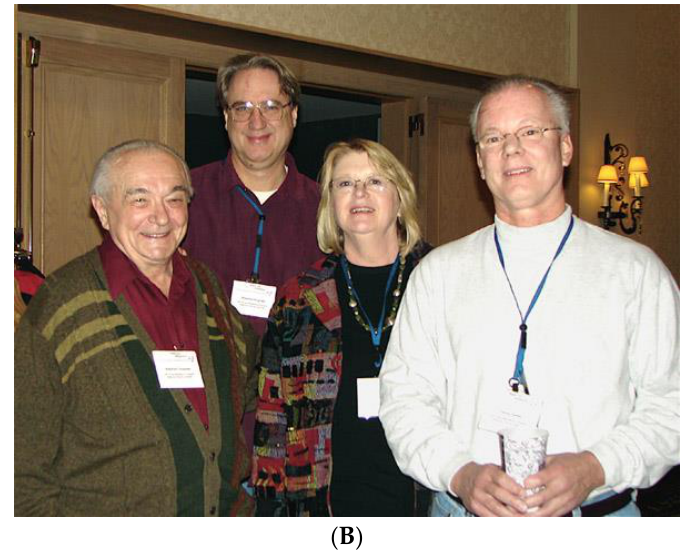
Figure 1. Steve Oroszlan in his element at meetings. ( A ) With Reuben Harris of the University of Minnesota; ( B ) with Steve Hughes, Gisela Heidecker, and Dave Derse, his colleagues at the NCI HIV Drug Resistance Program. Photos courtesy of Luis